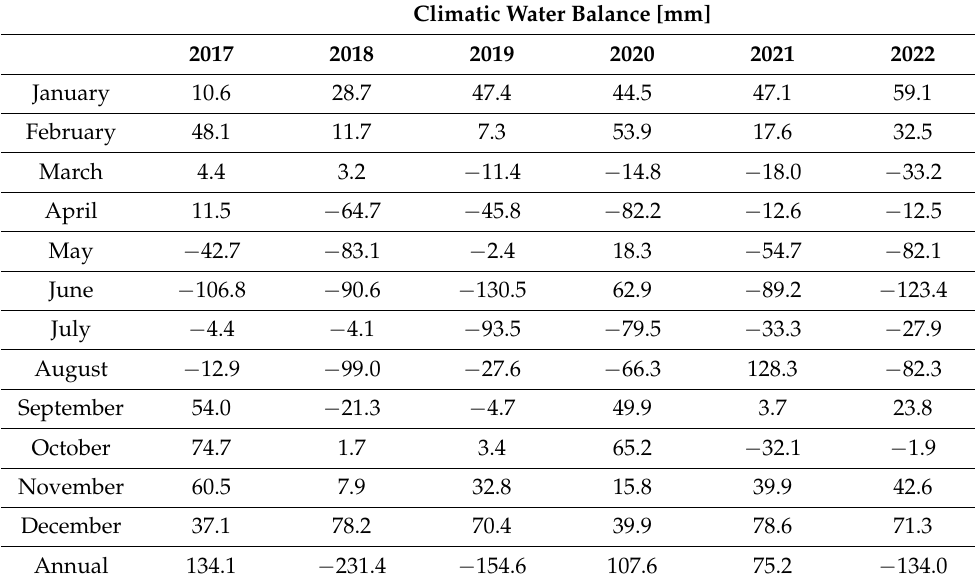
Table 6. Monthly and annual climatic water balance in Osiny for the period